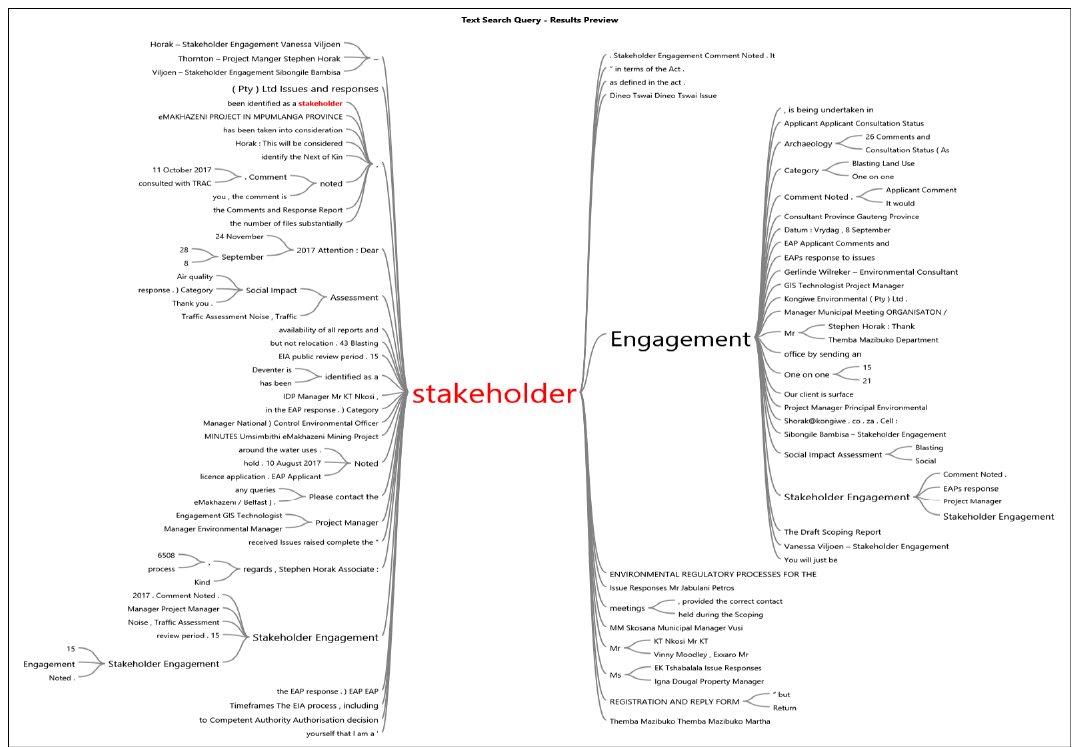
Figure A2: Word tree analysis for the Public Participation Report.